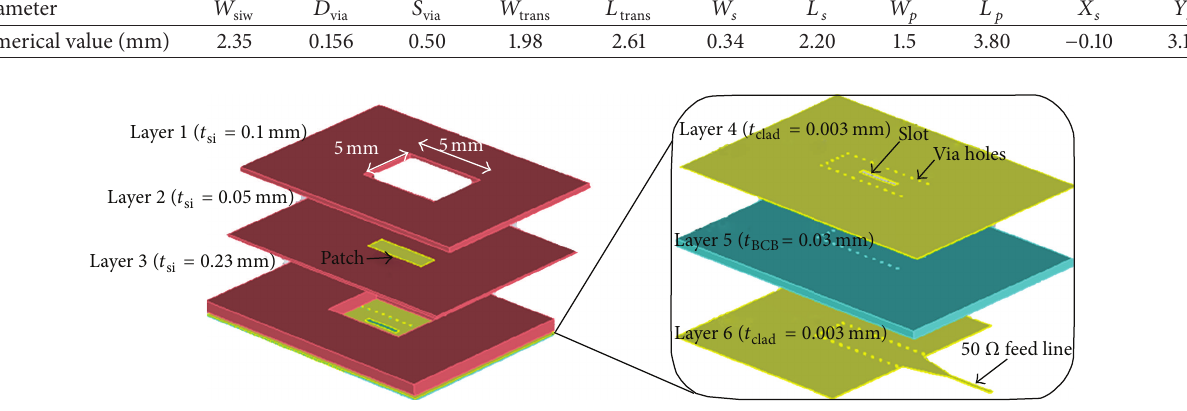
Figure 1: 3D exploded model